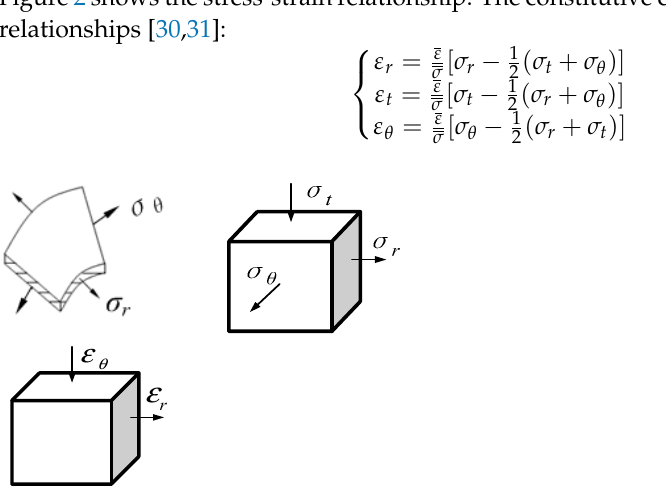
Figure 2. Stress-strain state of the contact deformation zone.